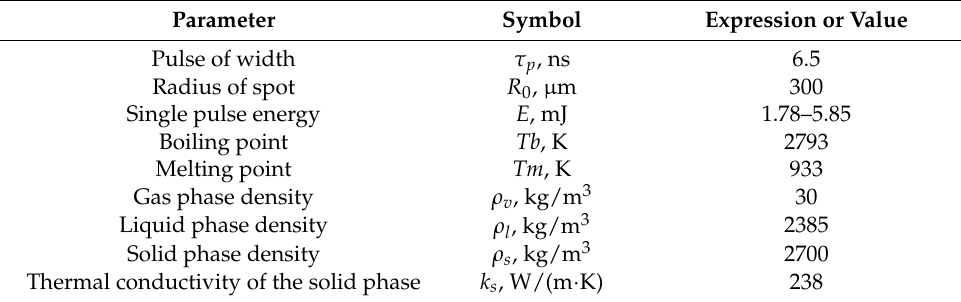
Thermal conductivity of the solid